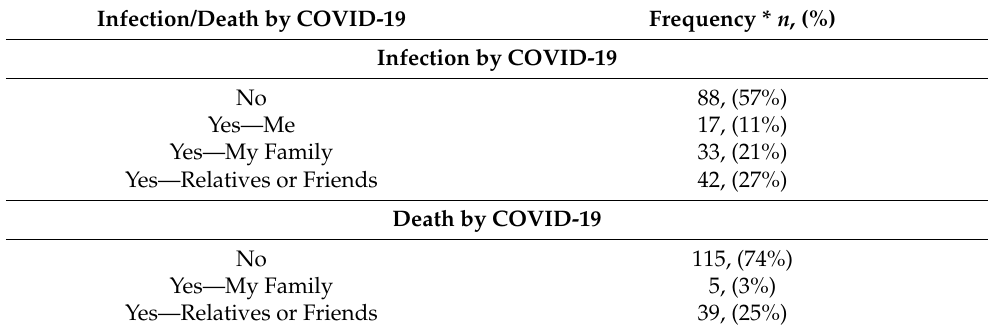
Table 2. Infection and death rate among participants because of COVID-19 ( n = 155 for each row). Infection/Death by COVID-19 Frequency * n , (%) Infection by COVID-19 No 88, (57%) Yes—Me 17, (11%) Yes—My Family 33, (21%) Yes—Relatives or Friends 42, (27%) Death by COVID-19 No 115, (74%) Yes—My Family 5, (3%) Yes—Relatives or Friends